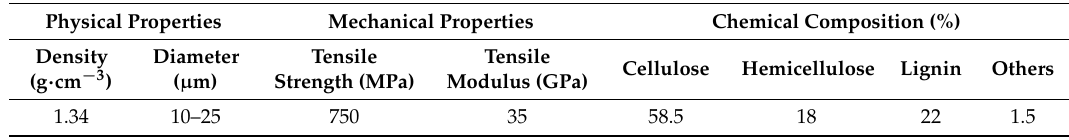
Table 1. Details of Bamboo fiber (BF) used in composites.